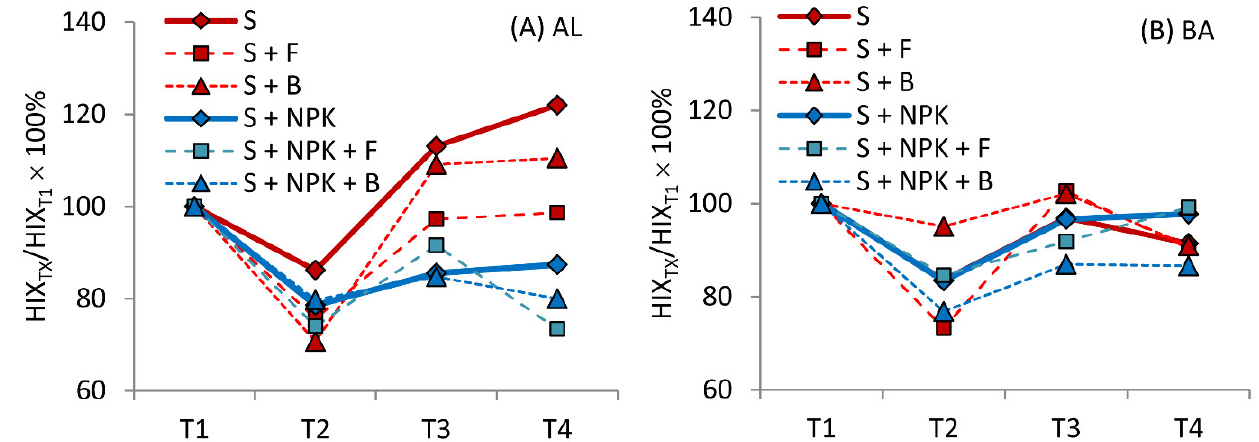
Figure 5. Changes in the humification index (HIX) for humic acids (HAs) from ( A ) Abruptic Luvisol (AL) and ( B ) Brunic Arenosol (BA) soils, expressed in the form of relative values. The values measured at T2, T3, and T4 were compared to the control values of the particular plot (100%) marked as T1 (Control, 100%). S—soil without additives, S + F—soil with fungal strains, S + B—soil with bacterial strains, S + NPK—soil with NPK, S + NPK + F—soil with fungal strains and NPK, S + NPK + B—soil with bacterial strains and NPK.